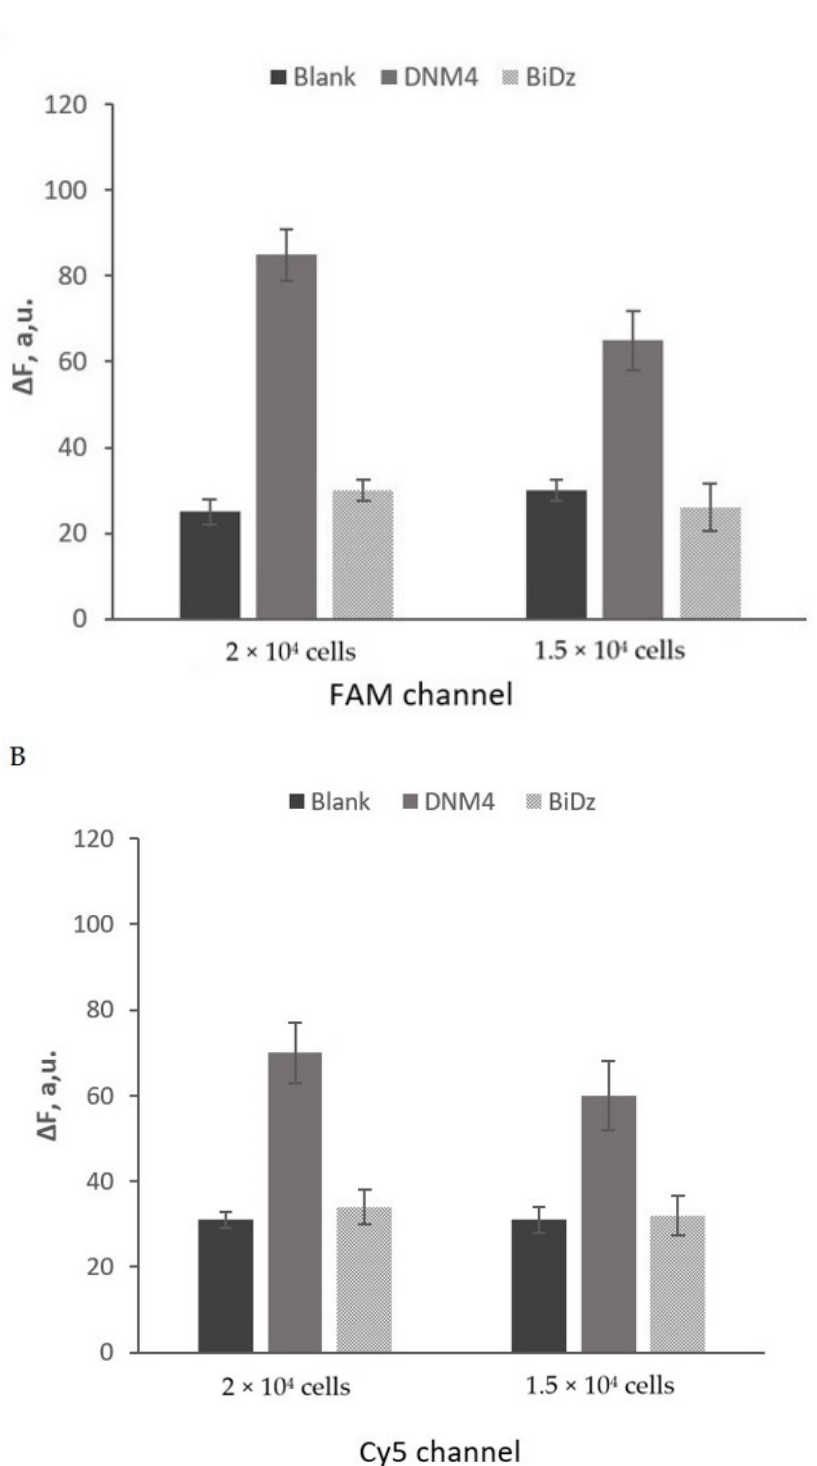
Figure 6. Response of DNM4 and BiDz to cell lysate. ( A ) Fluorescent intensity of Blank (no analyte) (dark gray bars), B. thuringiensis –specific DNM4 (light gray bars), or BiDz (striped bars) in the presence of B. thuringiensis cells (2 × 10 4 or 1.5 × 10 4 cells per reaction volume) in the FAM channel after 1 h of incubation at 55 ◦ C. ( B ) Fluorescent intensity of Blank (dark gray bars), B. mycoides –specific DNM4 (light gray bars), or BiDz (light grey bars) in the presence of B. mycoides cells (2 × 10 4 or 1.5 × 10 4 cells per reaction volume) in the Cy5 channel after 1 h of incubation at 55 ◦ C. Average values of three independent measurements are presented with one standard deviation. Tables S8 and S9 contain data correspond to Figures 6A and 6B,